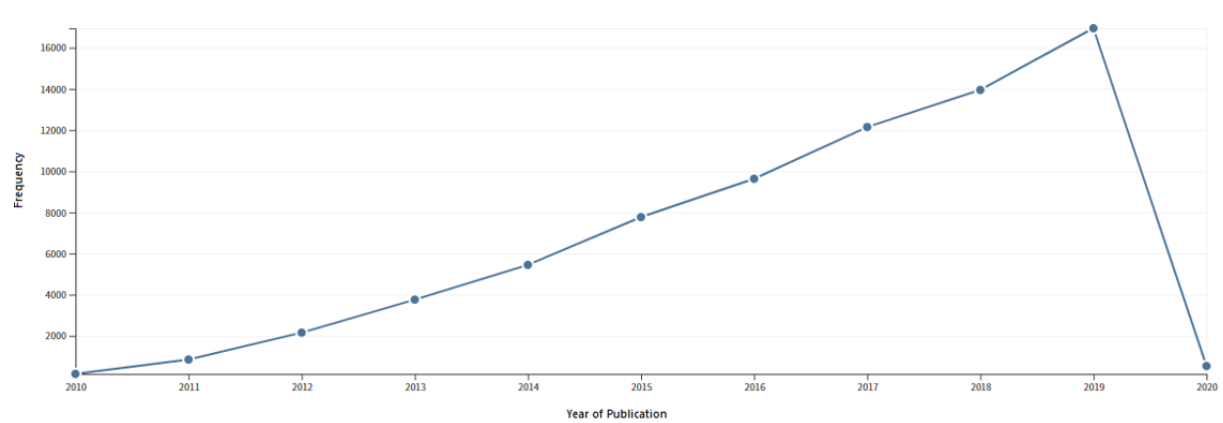
Figure 1. Trends of citations received by papers in